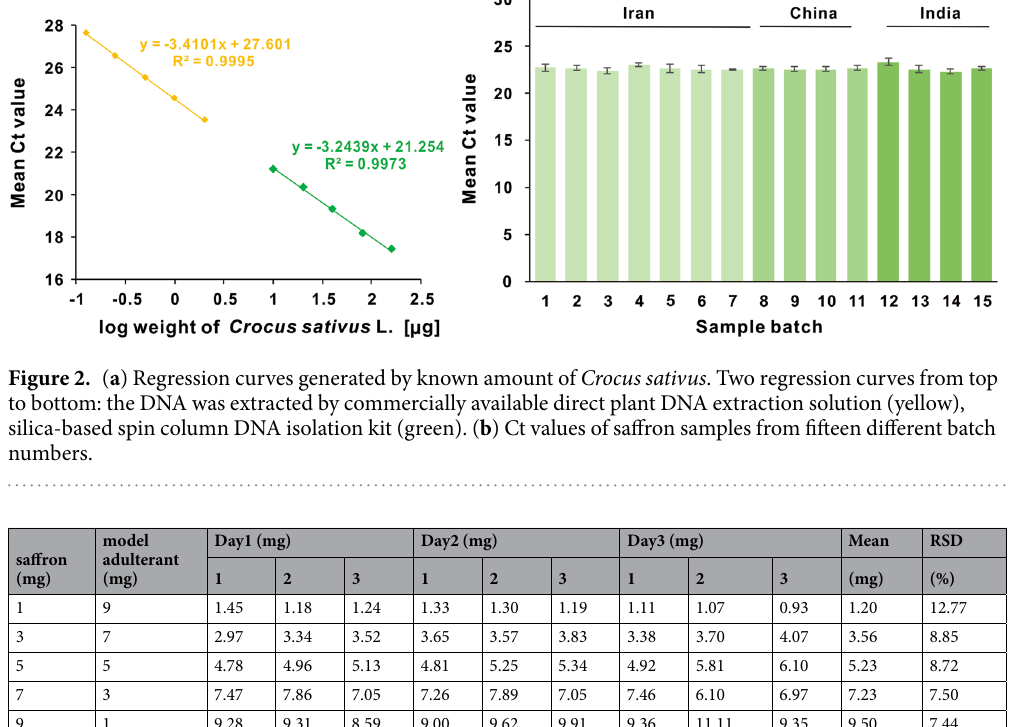
Table 1. Quantitative analysis of saffron in crude drug mixtures-original data of Fig. 3a. Note: Model adulterants were mixed by equal amount of C. tinctorius, Z. may and N. nucifera